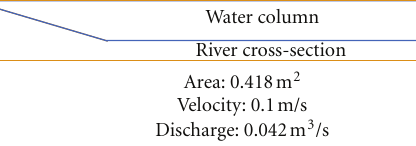
Figure 10: Average flow from eastern part of the catchment.